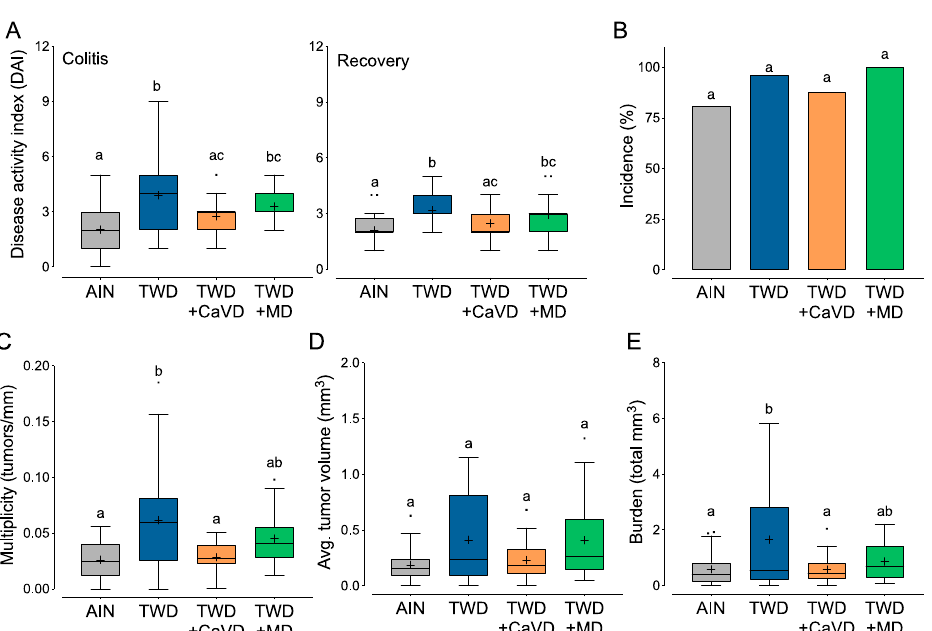
Figure 2. Restoration of calcium and vitamin D to amounts in the AIN diet suppressed colitis symptoms and inflammation-associated colon tumorigenesis in C57BL / 6J male mice fed TWD (Experiment B). Diet groups included the standard AIN93G diet (AIN), the total Western diet (TWD), the TWD with calcium and vitamin D restored to AIN amounts (TWD + CaVD) or the TWD with methyl donor micronutrients B 2 , B 6 , B 12 , folate, and choline restored to AIN amounts (TWD + MD). ( A ) Colitis disease activity index (DAI) score ( n = 29 to 32) at colitis and recovery time points. ( B–E ) Colon tumor outcomes include incidence ( B ), tumor multiplicity ( C ), average tumor volume per mouse ( D ), and burden as total tumor volume ( E ) ( n = 23 to 26). Data in all panels (except B) are shown as Tukey box plots (box, 25th to 75th percentiles; whiskers, 1.5 IQR; + , mean). Di ff erent letters indicate that treatment groups are significantly di ff erent ( p < 0.05) as determined by the appropriate linear mixed model or nonparametric test as outlined in the Materials and Methods.